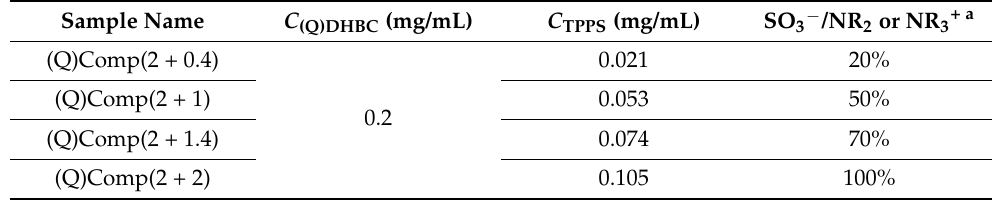
Table 2. Characteristics of the complex solutions of the DHBC or the QDHBC and TPPS